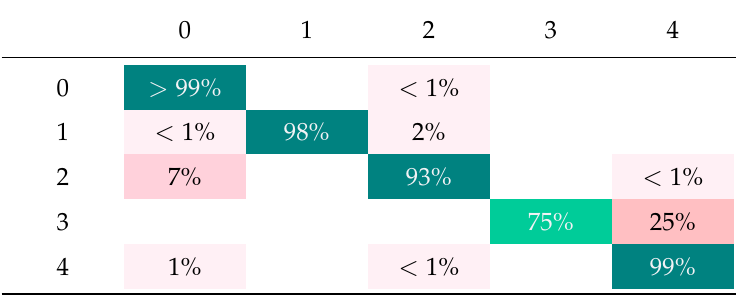
Table 7. Confusion matrix for the k -NN algorithm with k = 200 neighbors. The obtained accuracy is 95%. Label 0 corresponds to the healthy state, and labels 1, 2, 3 and 4 correspond to the damage state located at the corresponding level. In this matrix, each row represents the instances in a true class while each column represents the instances in a predicted class. An empty blank square means